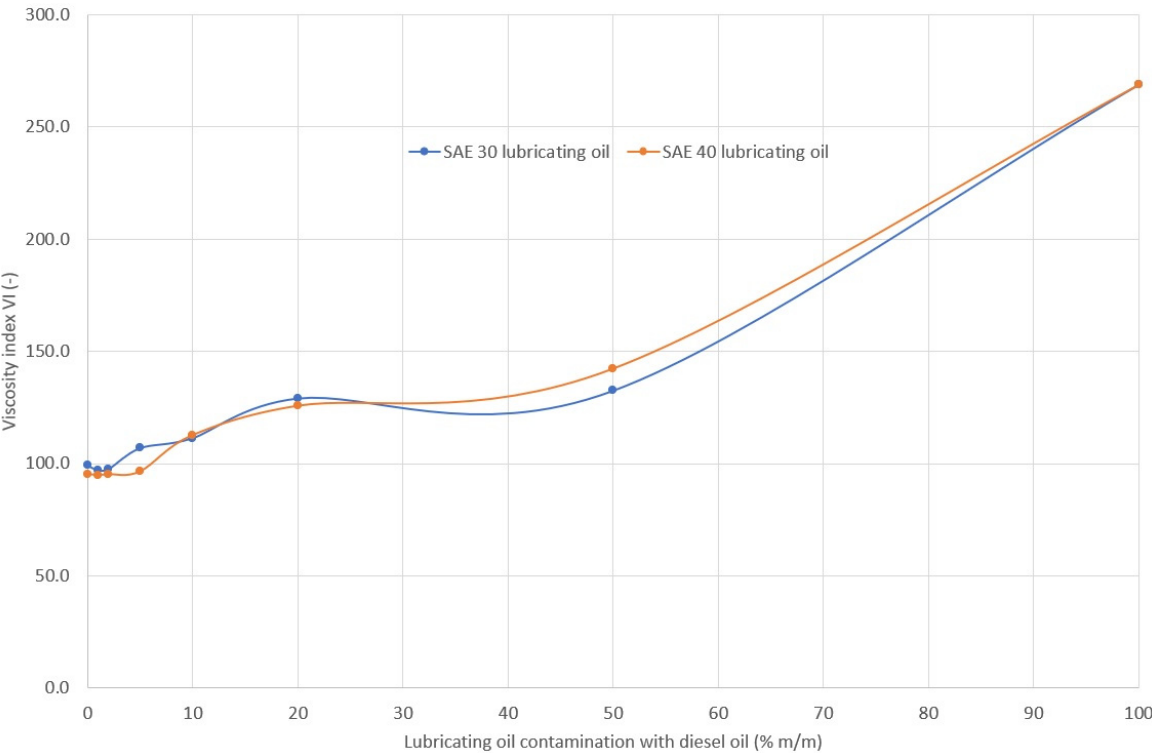
Figure 18. Calculated viscosity index values of the tested lubricating oils at different levels of lubricating oil dilution with diesel fuel.